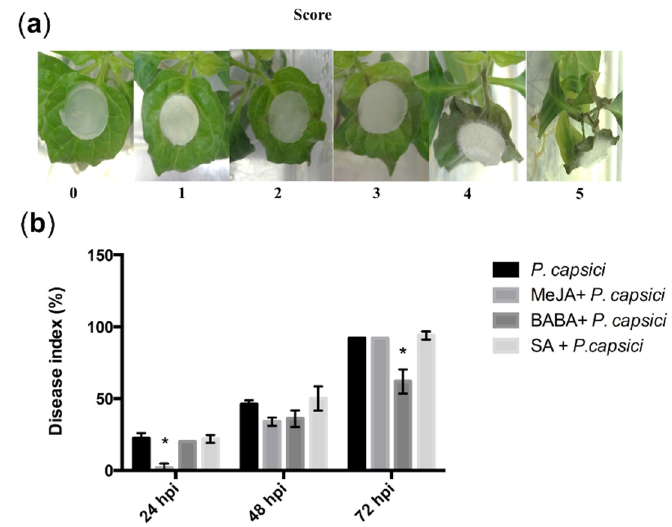
Figure 2. Effect of elicitors treatment on disease incidence caused (%) by P. capsici. ( a ) The scale of 0–5 in C . chinense infected with P . capsici , ( b ) quantity of the disease index (%) in Capsicum plants was sprayed with different eleicitors 24 h prior to inoculation with P . capsici , was measured 24, 48, and 72 h after inoculations. The asterisk indicates statistically significant differences between pathogen-inoculated and treatments-inoculated (range test p < 0.05).